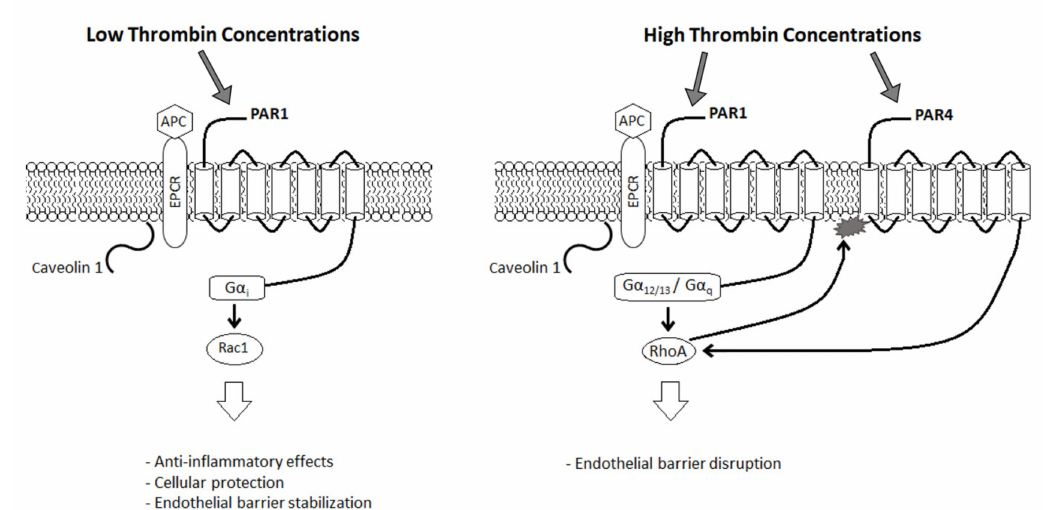
Figure 2. Role of thrombin in cellular protection and apoptosis. At low concentrations, thrombin has anti-inflammatory effects and is involved in cellular protection and endothelial barrier stabilization. At high concentrations, thrombin leads to endothelial barrier